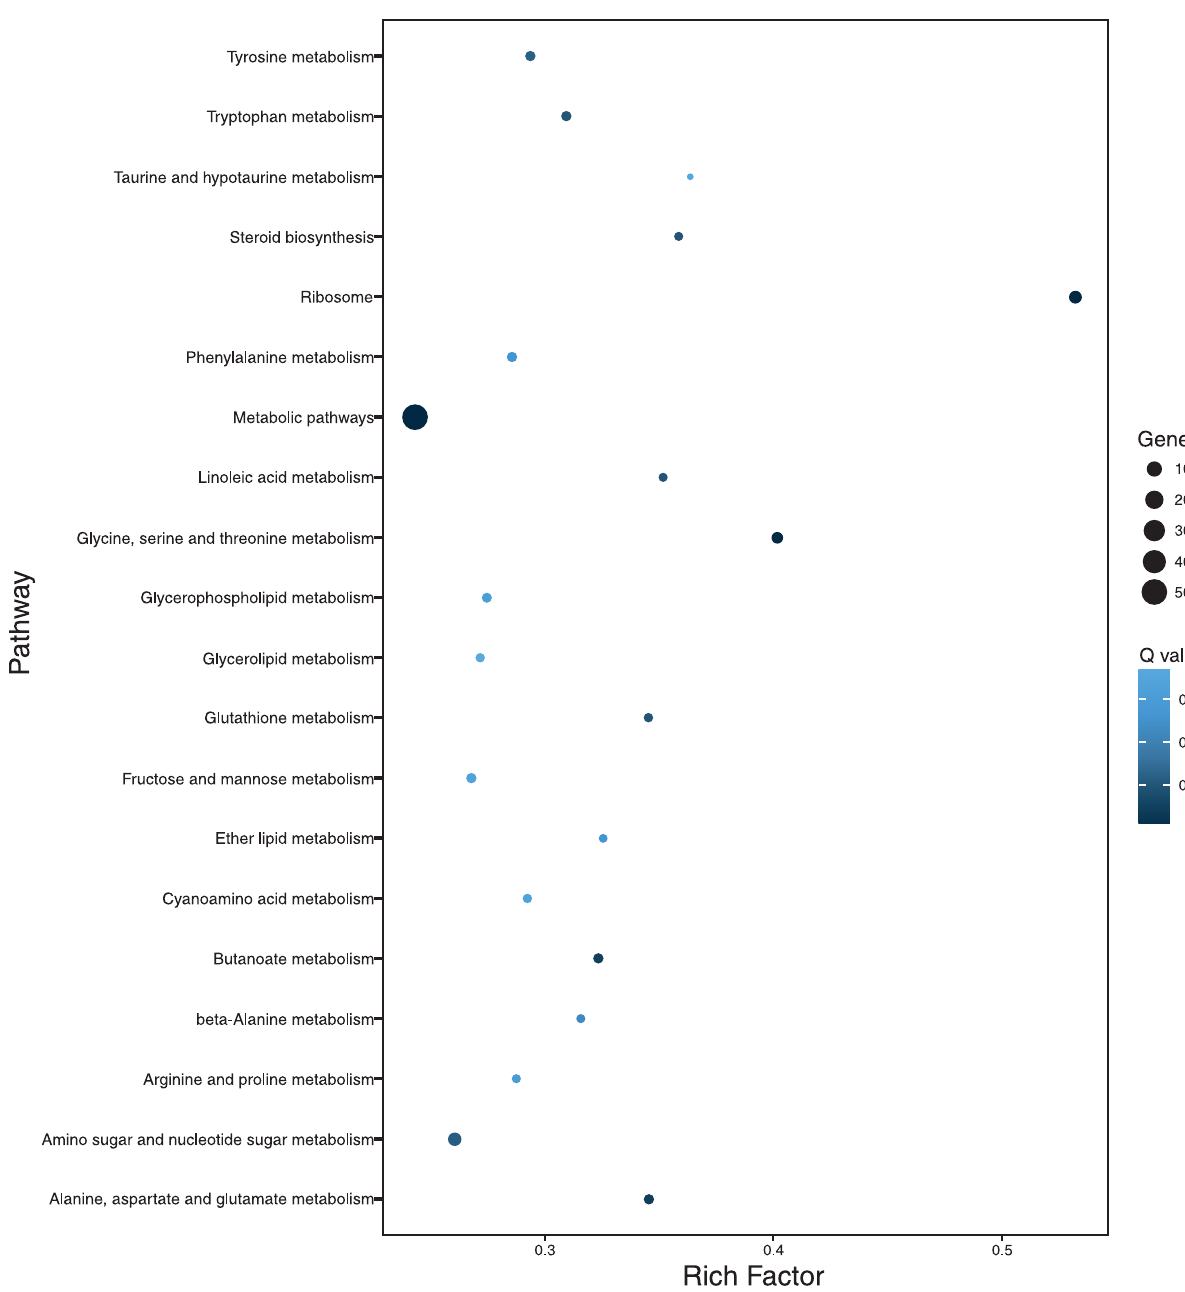
Fig 5. Kyoto Encyclopedia of Genes and Genomes (KEGG) enrichment scatter plot. Twenty most enriched differential expressed genes (DEGs) of RNA-seq analysis of Aspergillus terreus incubated at 25 ˚C and pH 7 and at 45 ˚C and pH 3; y-axis = name of pathway, x-axis = rich factor, dot size = number of different genes, color =